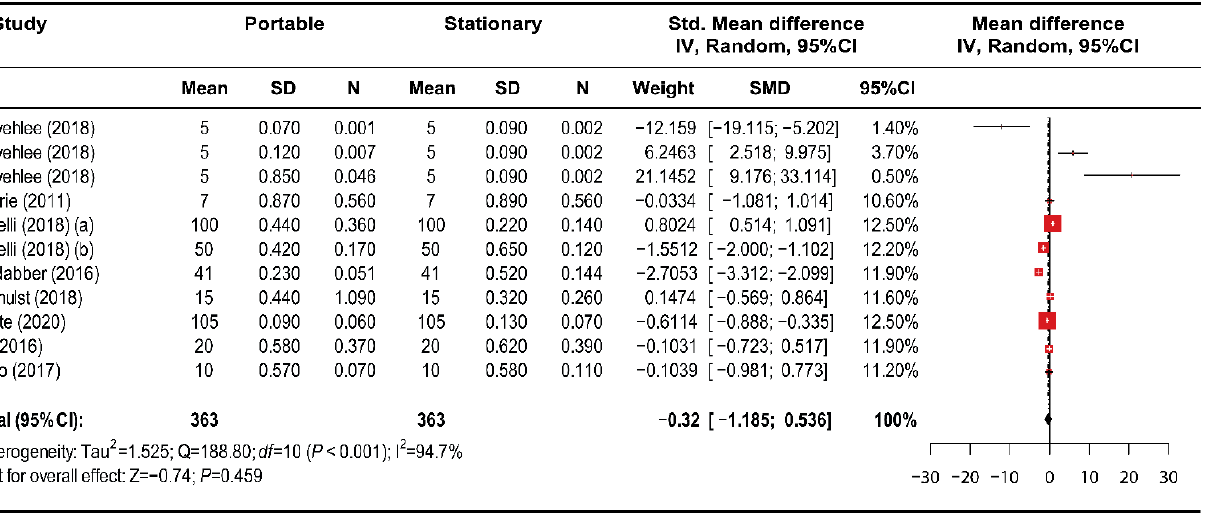
Figure 3. Meta-analysis results of the comparison between the use of portable and stationary face-scanning systems for generating digital face models.